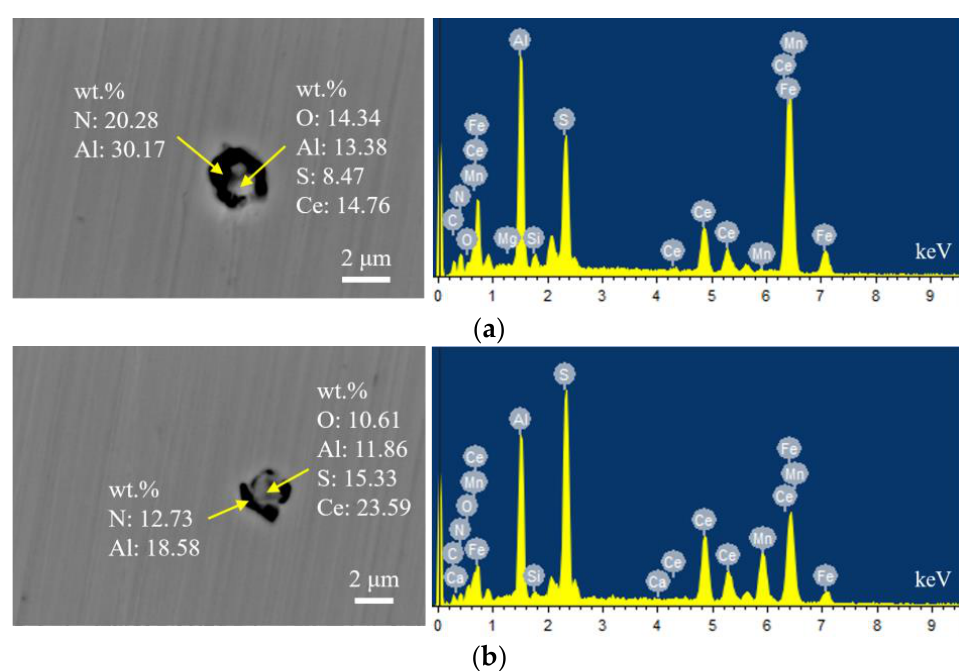
Figure 4. Typical morphology and energy spectrum of inclusions in the steel with 14 ppm Ce content. ( a ) Inner layer: CeAlO 3 -Ce 2 O 2 S, Outer layer: AlN, ( b ) Inner layer: CeAlO 3 -Ce 2 O 2 S, Outer layer: AlN.